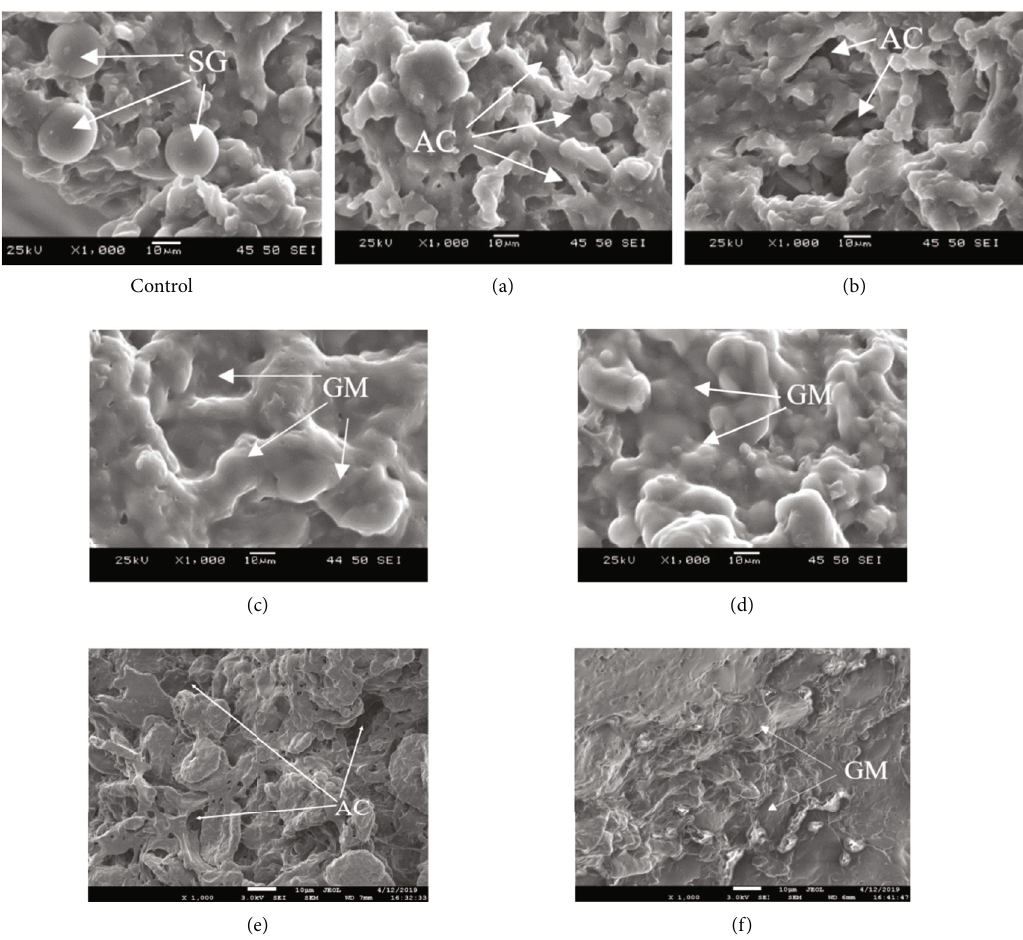
Figure 6: The microstructure of the bread crumb after 3 hours storage: SG: starch grains; GM: gluten matrix; AC: air cavity. Table 2: Results of determining the speci fi c volume and moisture content of